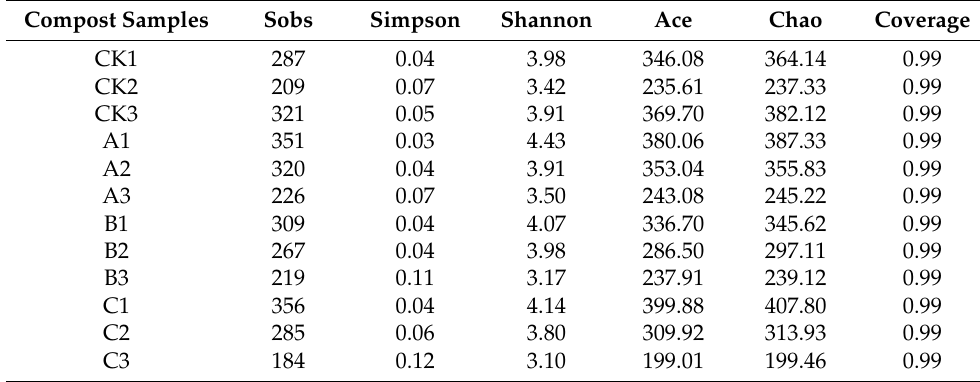
Table 2. Bacterial alpha diversity indices at different composting stages. Compost